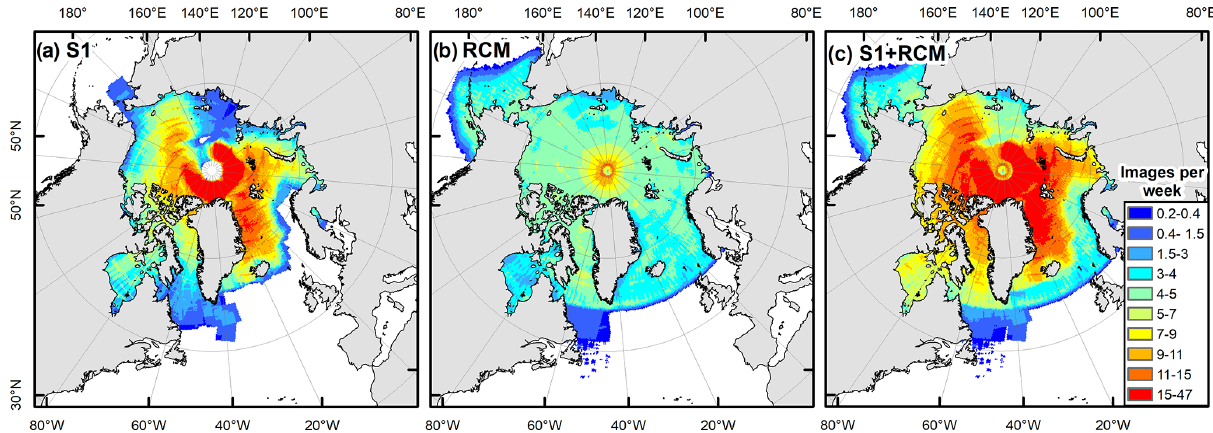
Figure 3. Image density per week for (a) S1, (b) RCM, and (c) S1 + RCM based on Table 1.